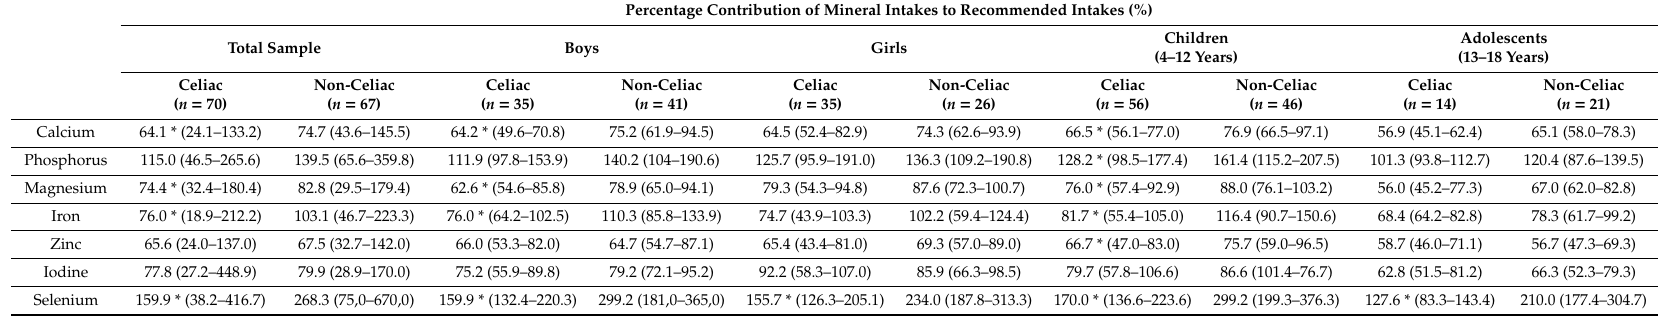
Table 6. Adequacy of mineral intakes in the diet of celiac and non-celiac children and